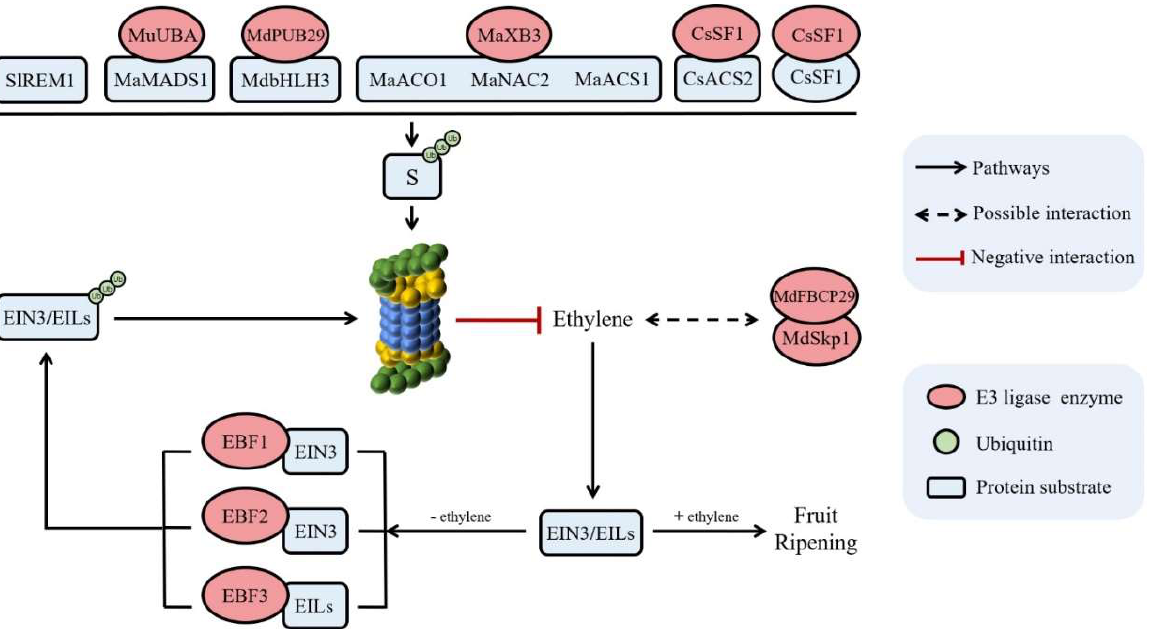
Figure 2. The function of the ubiquitin–26S proteasome pathway in ethylene biosynthesis and signal transduction pathway. S: substrate proteins, such as SlREM1, MaMADS1, MdbHLH3, MaACO1, MaNAC2, MaACS1, CsACS2, and CsSF1.